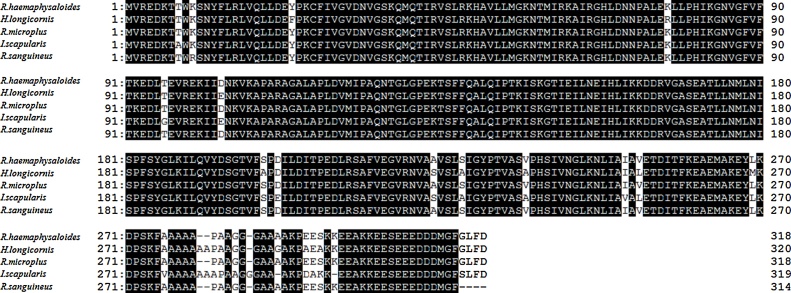
Alignment of the deduced protein sequences of P0 from R. haemaphysaloides and other tick species. Identical residues are shaded black. The protein sequence accession numbers for H. longicornis, R. microplus, I. scapularis, R. sanguineus and R. haemaphysaloides are ABW16870.1, AGQ49465.1, AAY66850.1, AJQ18906.1 and ALJ02546.1, respectively.